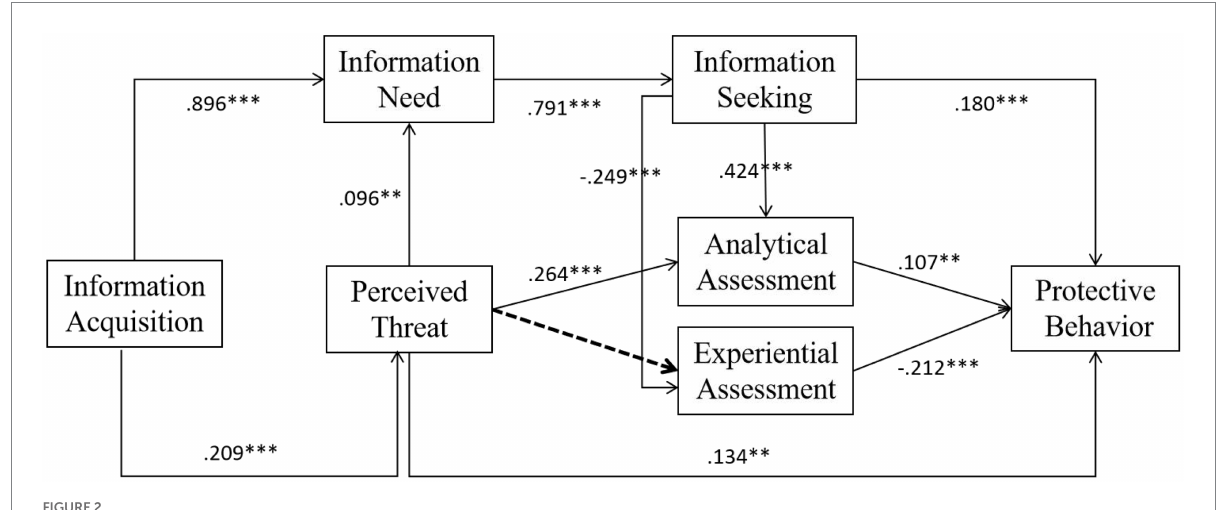
FIGURE 2 Results of conceptual model. ** p < 0 0.05 and *** p <